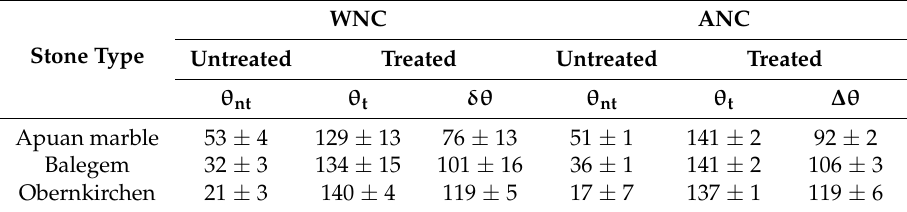
Table 9. Static contact angles ( θ , in degrees) of untreated ( θ nt ) vs. treated ( θ t ) lithotypes and Δθ values (= θ t − θ nt ).